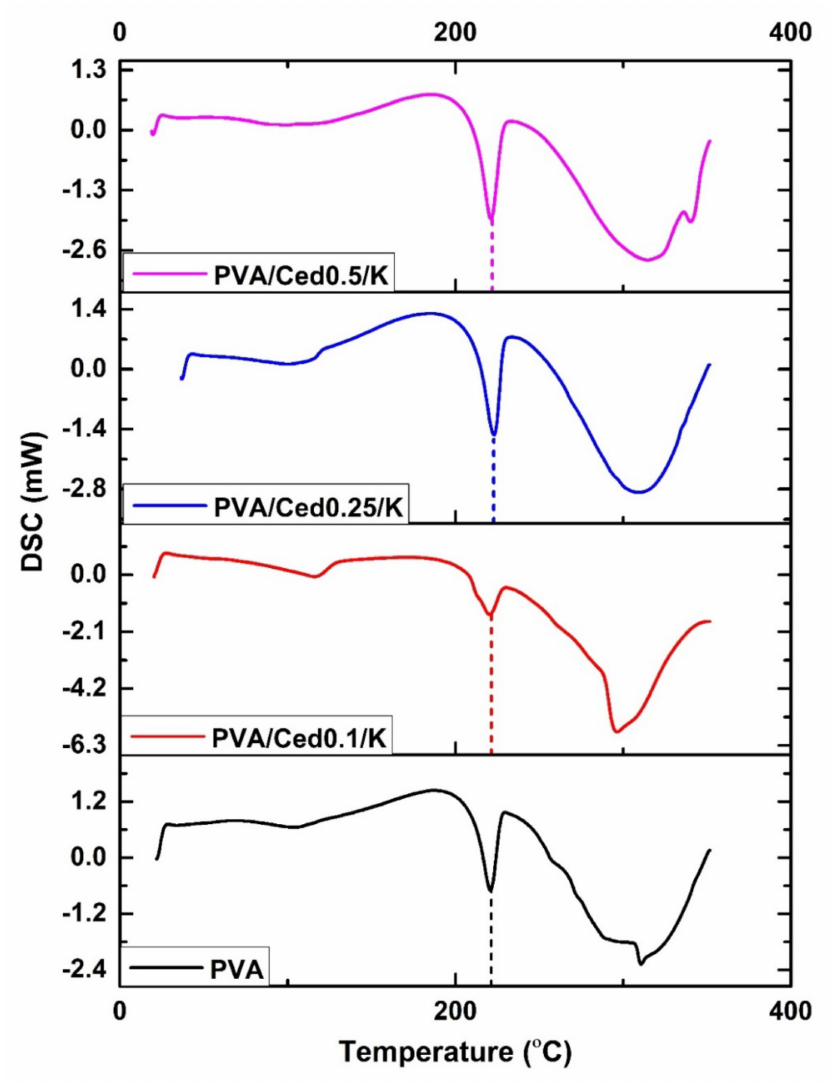
Figure 4. DSC analyses of PVA/Ced/K composite